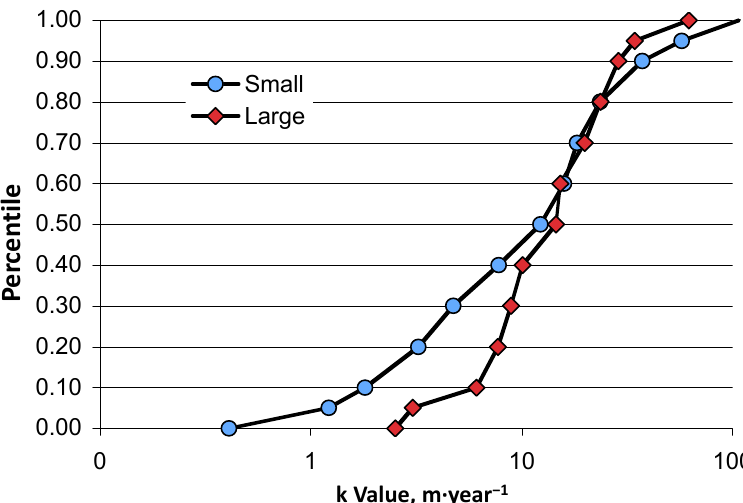
Figure 3. Distributions of P removal rate coefficients for large ( N = 43) and small ( N = 87) constructed wetlands. A plateau concentration of 6 mgP·m − 3 has been used. Large wetlands are assumed to have a distribution of detention times represented by eight tanks in series, and for the small dataset three tanks in series.